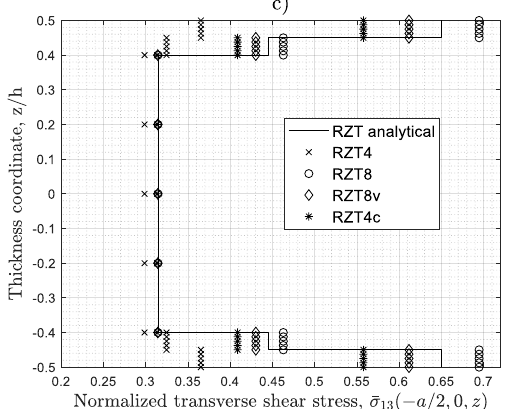
Figure 18. Non-dimensional bending and transverse shear stresses. Simply supported sandwich (S) square plate under uniform transverse pressure ( a / h = 8). ( a ) Normalized in-plane stress ( σ 11 ) ; ( b ) Normalized in-plane stress ( σ 22 ) ; ( c ) Normalized transverse shear stress ( σ 13 )